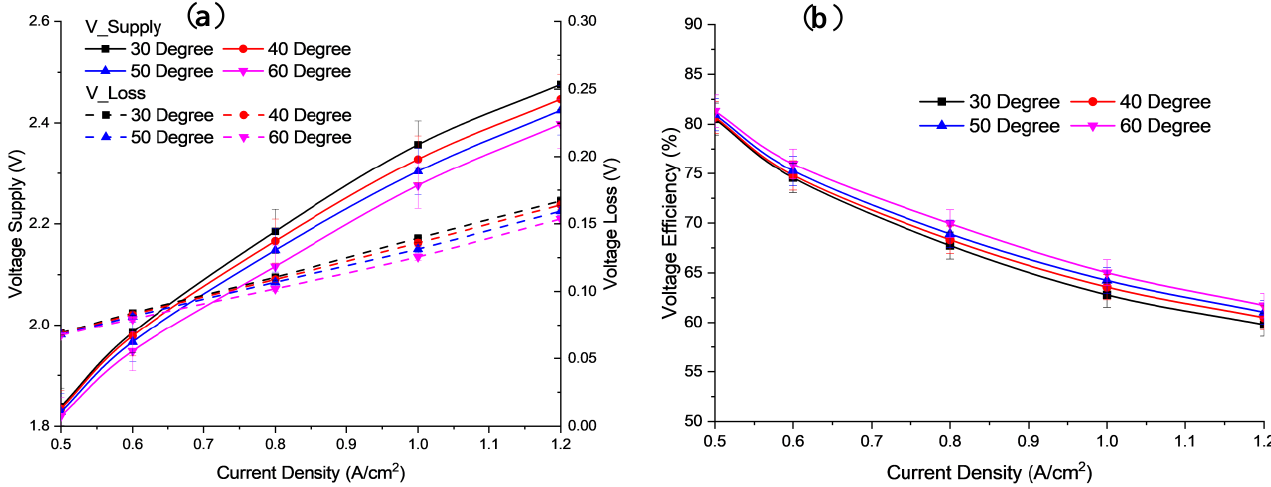
Figure 5. Profile of ( a ) Polarization curve, ( b ) Voltage efficiency for different operating temperatures at 6 mL/min flow rate and concentration of electrolyte 2.0 M KOH.